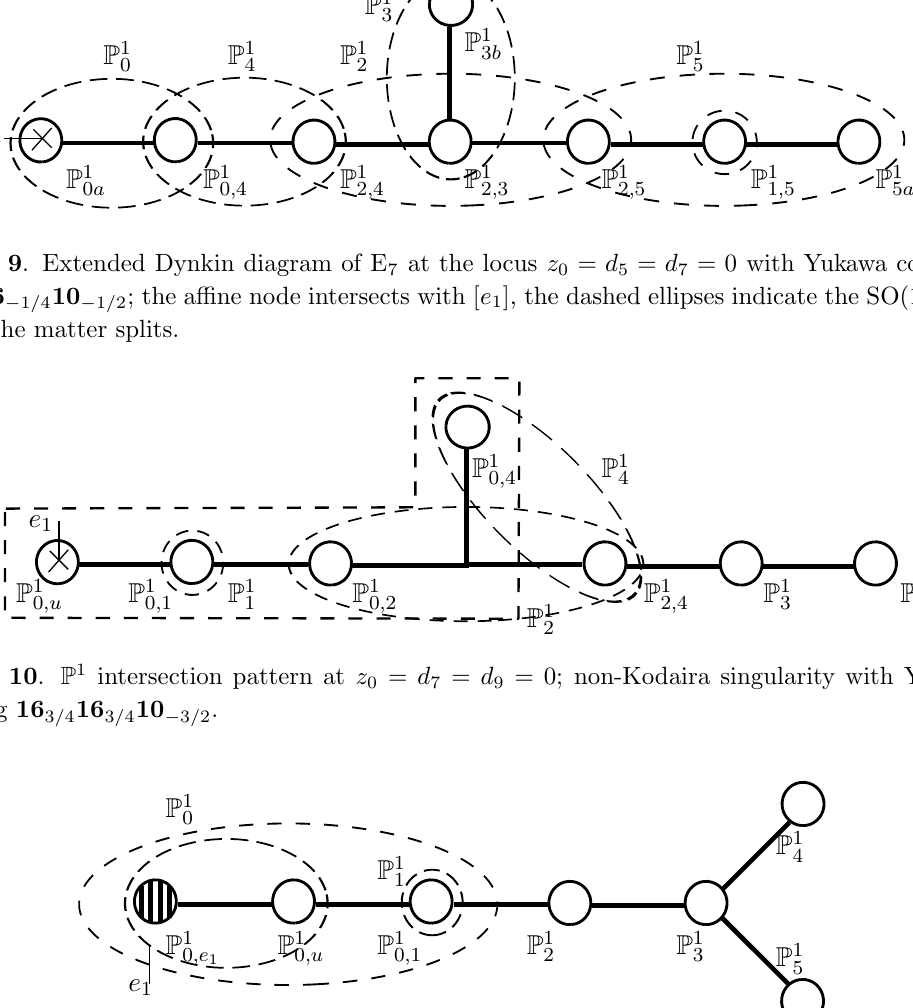
0 = d 8 = d 9 ; non-Kodaira singularity with Yukawa coupling